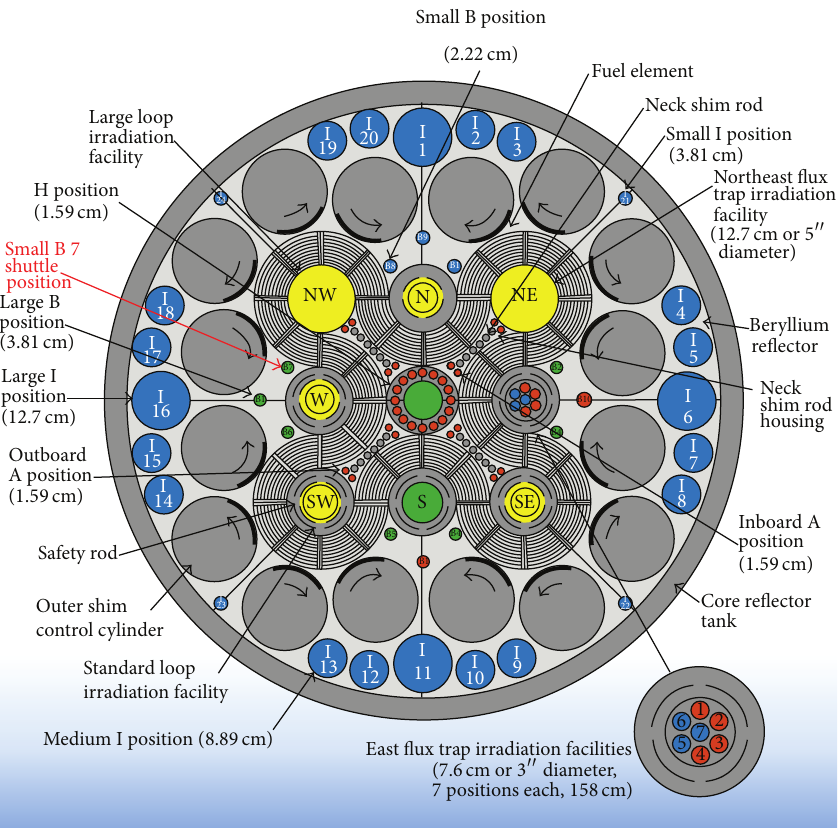
Figure 8: ATR core cross-section—4 flux traps, 5 in-pile tubes, and 68 in reflector—[10].